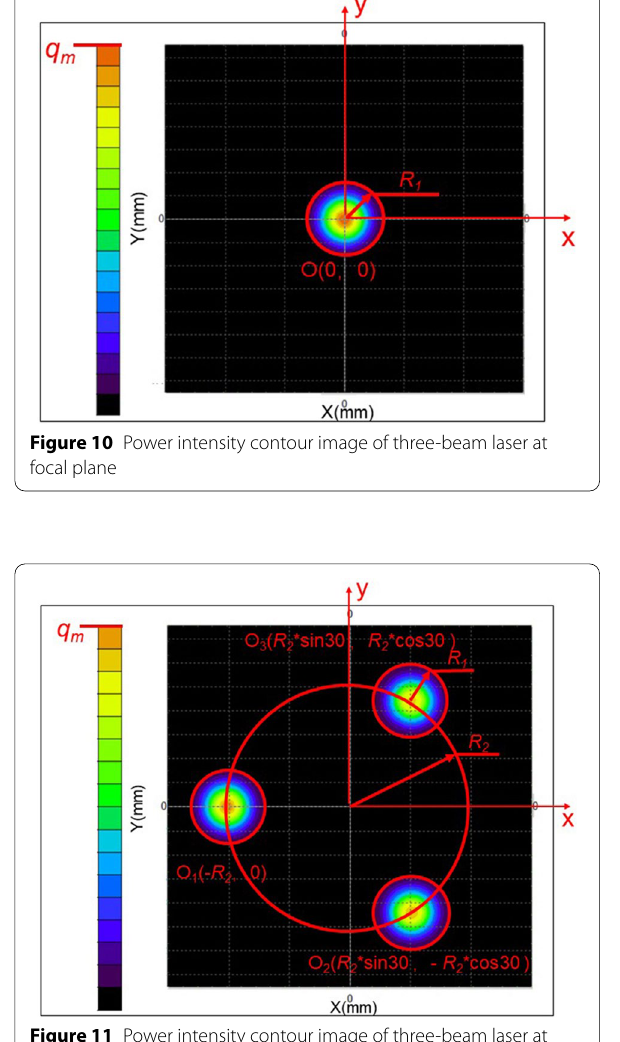
A contour image of the laser power intensity at the focal plane where the three beams merge is shown in Fig- ure 10. The power intensity distribution at the focal plane is expressed as follows: The contour image of the power intensity and dimension of the laser beam at the positive cross-section is shown in Figure 11. The power intensity distribution in the positive region is expressed as follows: